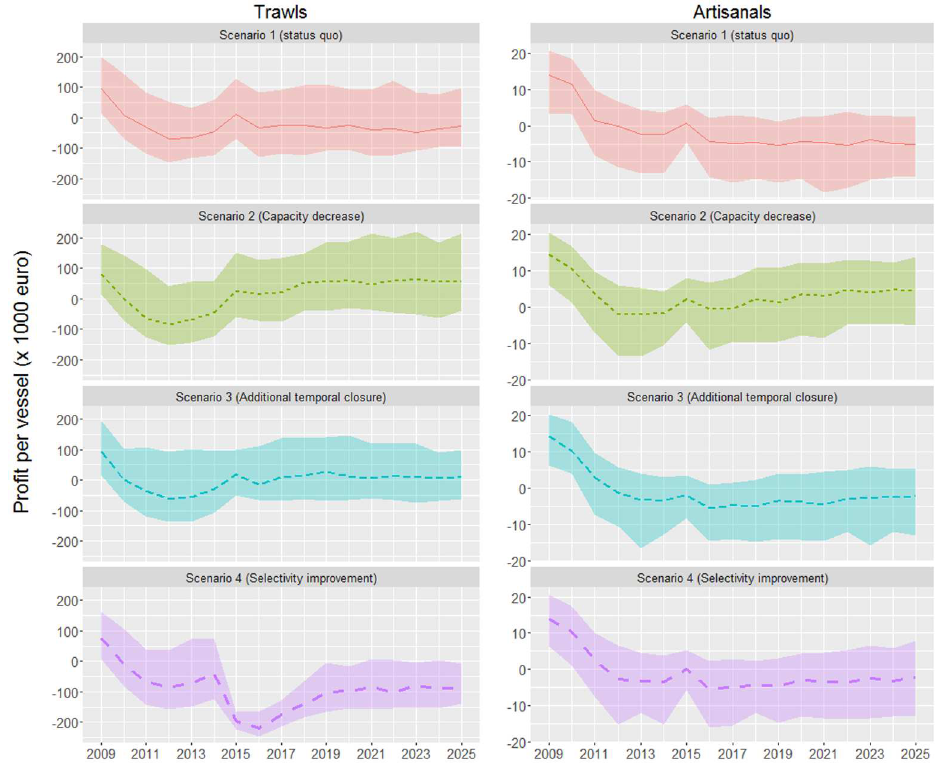
Fig 5. Profit per vessel(in 10 3 € ) for the trawl (left graph) and artisanal fleet (right graph) under the four simulated scenarios, assuming that fuel prices from 2016 onwards are equal to the 2013 mean rate. Lines indicatethe median estimates and the upper and lower limits of each ribbonrepresent the 0.1 and 0.9